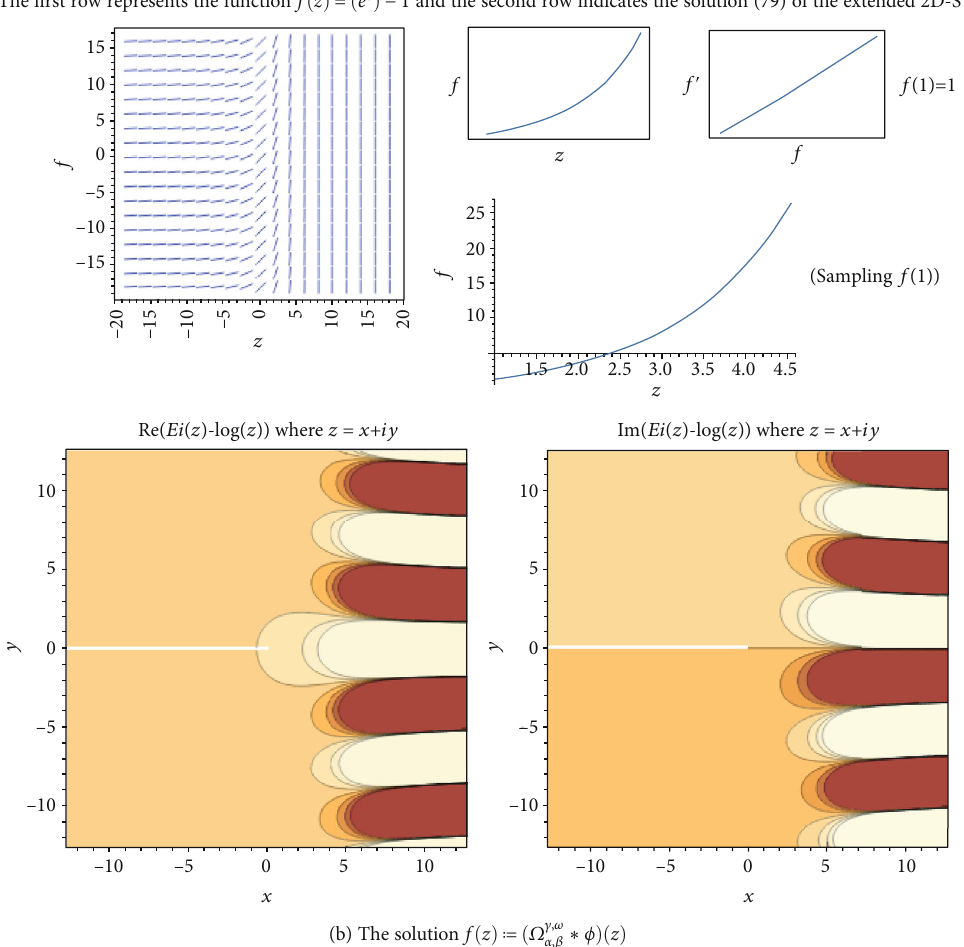
Figure 1: Saint-Venant equations (2D-SVE) of di ff usive